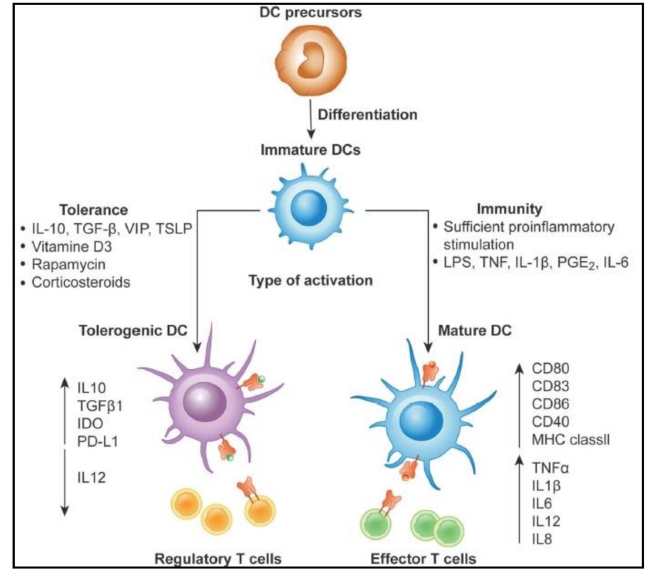
Figure 4. Differentiation of DCs is critical for efficient immune surveillance. Differentiation of tolerogenic vs. activated DCs generated from monocytes. In the presence of IL-4 and GM-CSF, DCs develop from DC precursors into immature DCs (iDCs). DCs become activated and change to a stimulatory phenotype in the presence of a maturation signal (proinflammatory cytokines and toll-like receptor ligands), which then triggers the development of effector/cytotoxic T cell responses. Reproduced with permission from [56]. Copyright 2019, Frontiers Media